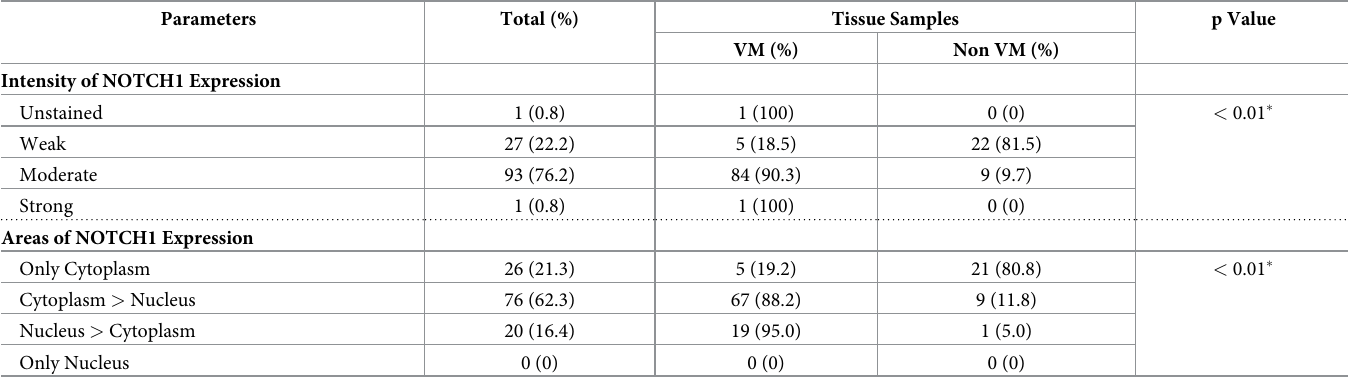
Table 2. Association of VM and NOTCH1 expression and localization in